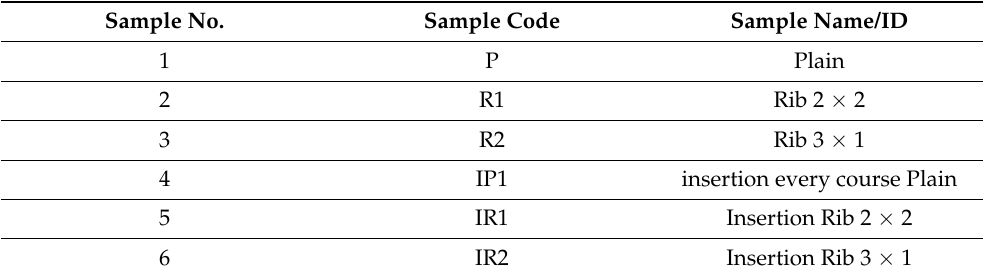
Table 2. Experimental samples and codes.